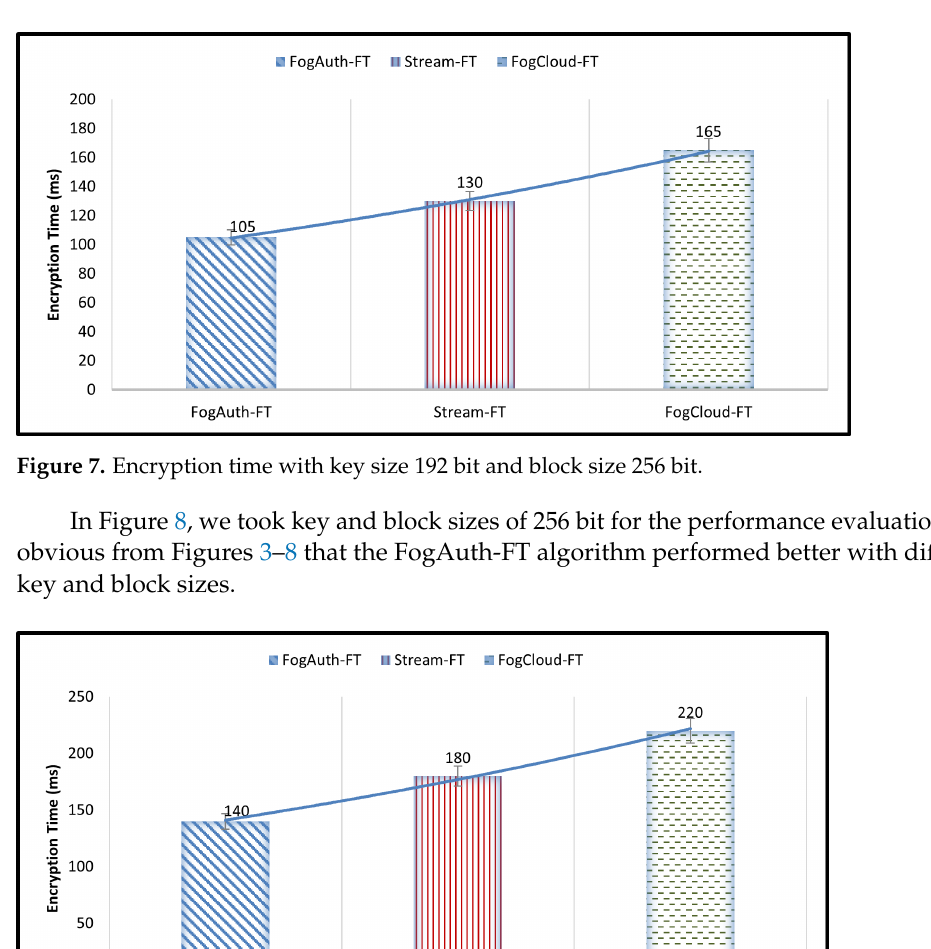
Figure 6. Encryption time with key size 128 bit and block size 256 bit.